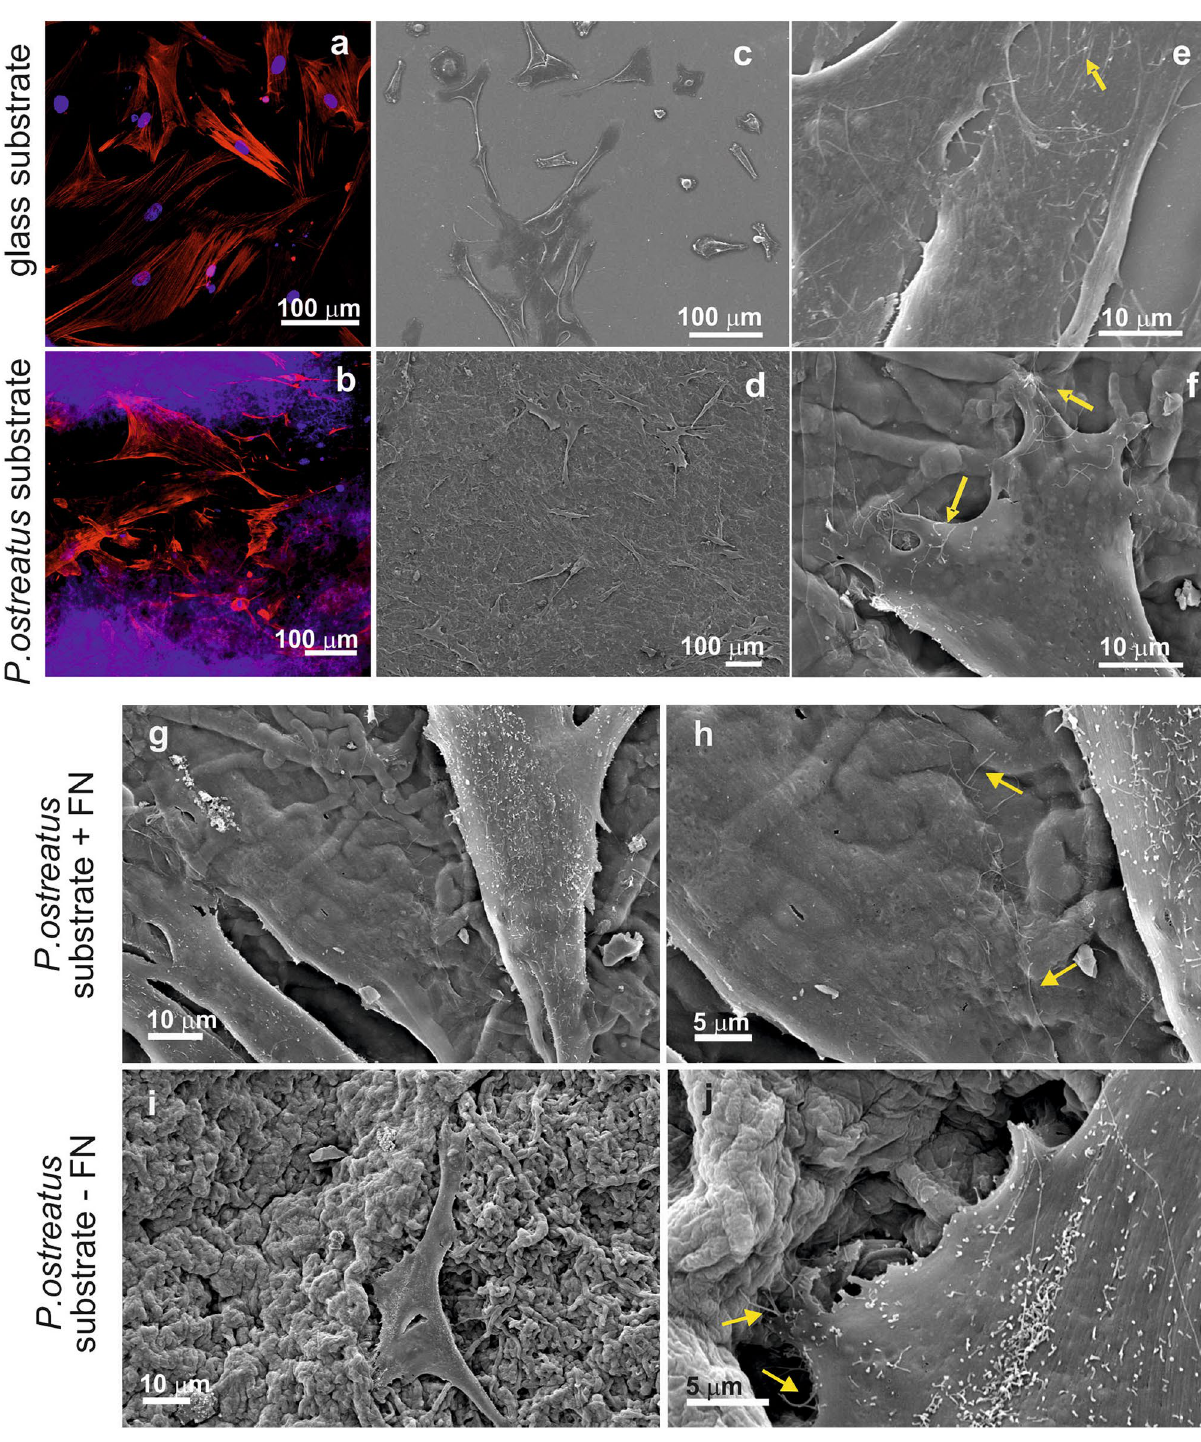
Figure 5. Confocal ( a ) and SEM micrographs ( c , e ) of HDFa cells grown for 48 h onto a FN-coated glass coverslips. Confocal ( b ) and SEM micrographs ( d , f ) of HDFa cells grown for 48 h onto a FN-coated P. ostreatus substrate. Nuclei are stained with DAPI (visible in blue), while the actin fibers are stained with Alexa Fluor Phalloidin 488 (highlighted in green). Filopodia extending from the cytoplasm of the attached cells are indicated with yellow arrows. ( g – j ) Effect of the scaffold coating onto primary cell growth. HDFa cells are seeded onto P. ostreatus scaffolds, either coated with fibronectin ( g , h ) or uncoated ( i , j ). Filopodia extending out of the attached cells are highlighted with yellow